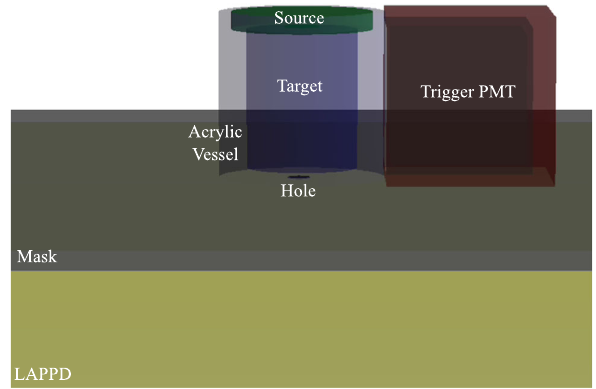
Fig. 4 The geometry of the setup, shown in Fig. 3, visualized looking from the side of the LAPPD in